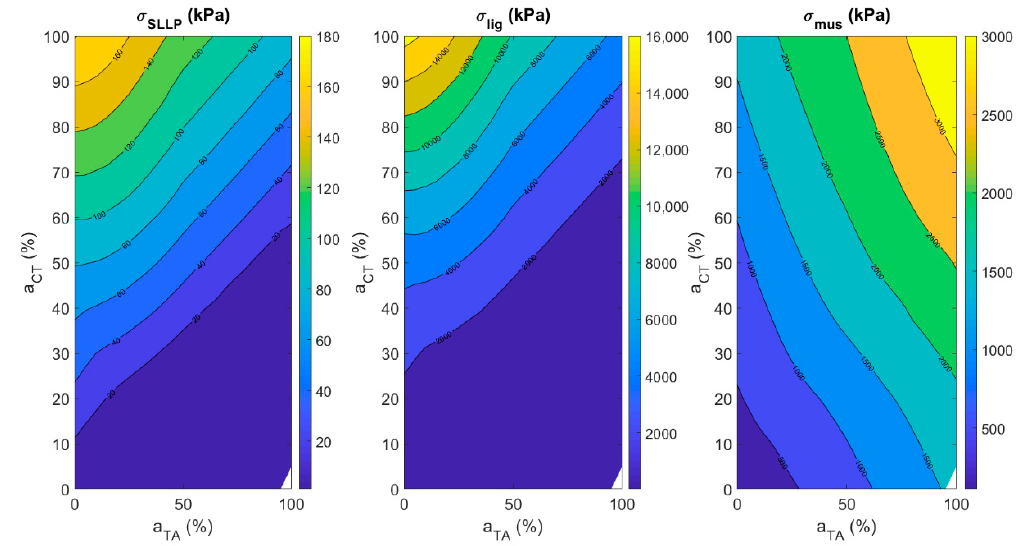
Figure 11. Muscle activation plots for fiber stress in ( left ) SLLP layer, ( center ) ligament layer, and ( right ) TA muscle with respect to TA–CT muscle